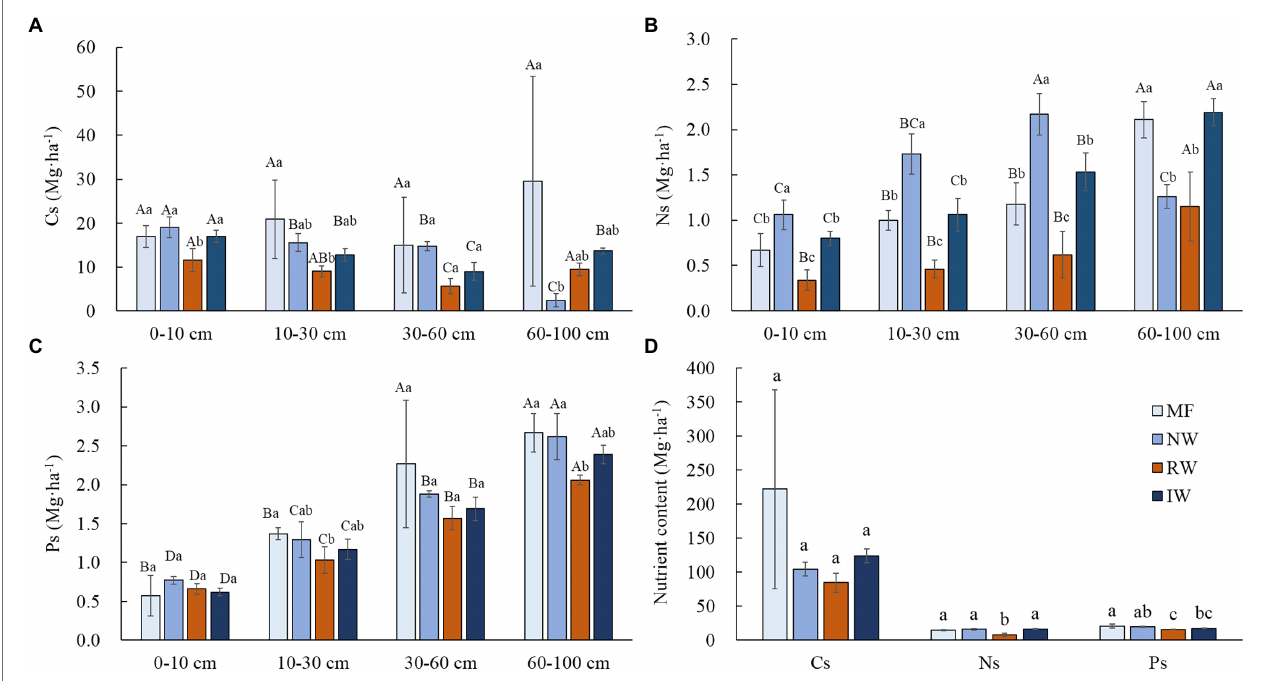
FIGURE 4 | Distributions of the soil C stock (A) , soil N stock (B) , soil P stock (C) , and total soil nutrient stock ( D ; means ± SD, n = 3) under different land-use types in Hangzhou Bay. Cs, soil C stock; Ns, soil N stock; and Ps, soil P stock. Different capital letters in the same wetland type indicate a significant difference among soil depths at p < 0.05, and different lower-case letters in the same soil depth indicate a significant difference among wetland types at p < 0.05.